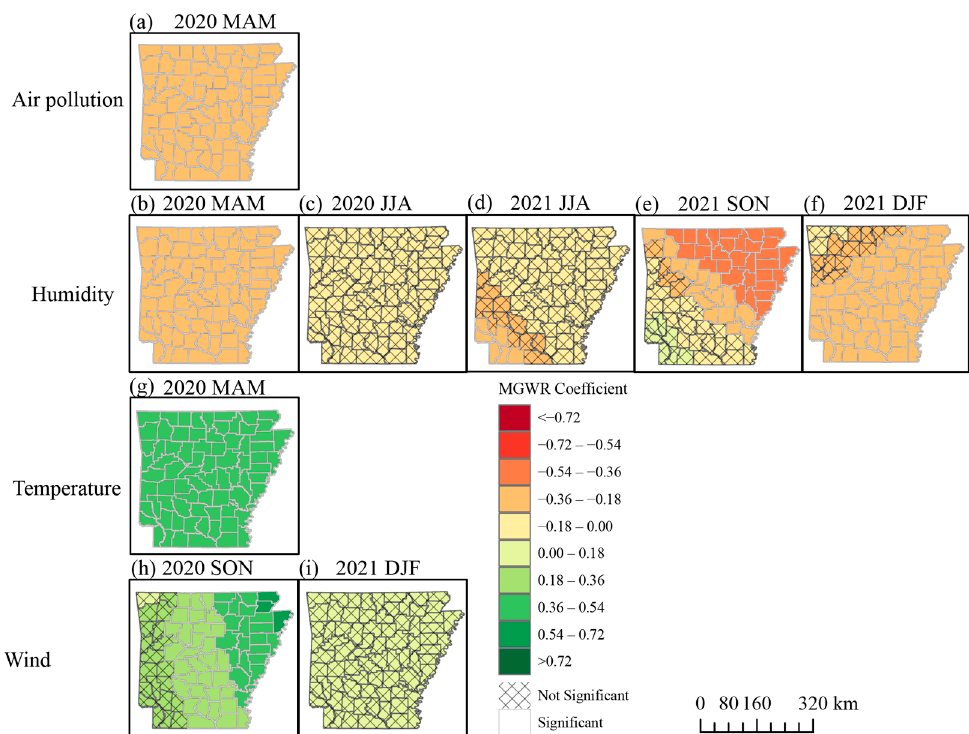
Figure 8. Spatial impacts of climate variables on the COVID-19 rate derived from a geographically weighted regression model on COVID-19 in each county in Arkansas, US from 2020 to 2021. The unhatched regions indicate a 5% significance level. (MAM: March–April–May; JJA: June–July– August; SON: September–October–November; DJF: December–January–February).